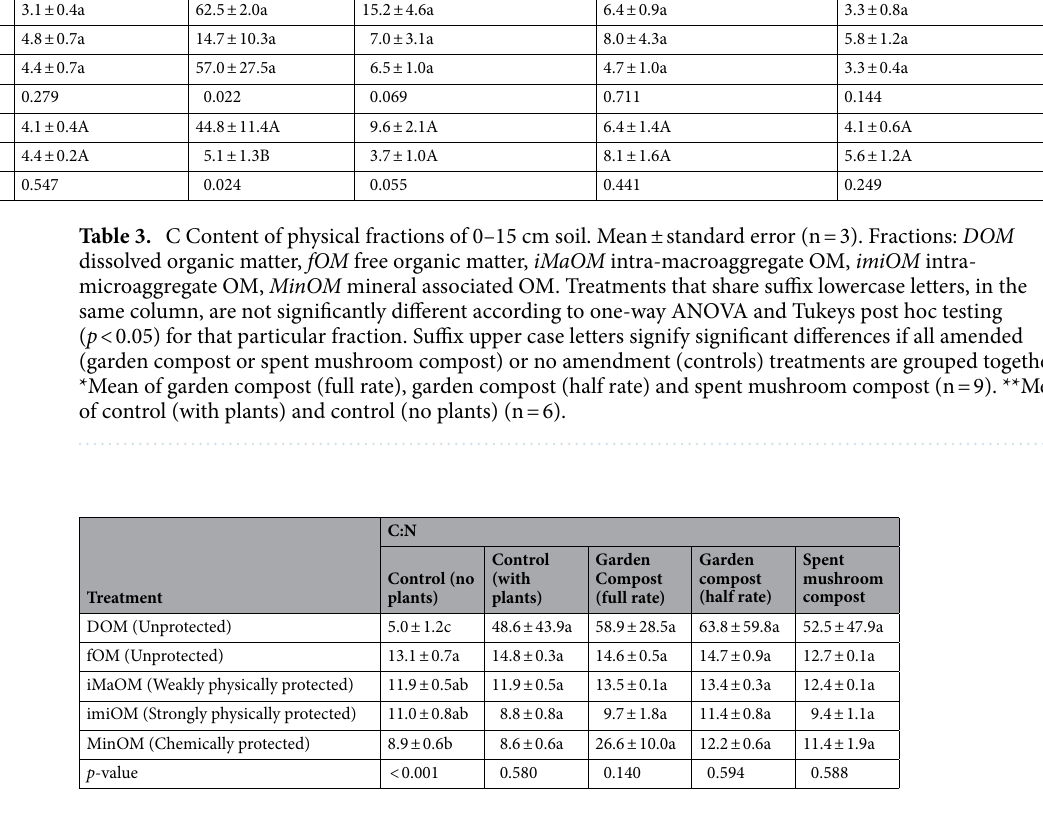
Table 4. C:N of physical fractions of 0–15 cm soil. Mean ± standard error (n = 3). Fractions: DOM dissolved organic matter, fOM free organic matter. iMaOM intra-macroaggregate OM, imiOM intra-microaggregate OM, MinOM mineral associated OM. Fractions that share suffix lowercase letters, in the same column, are not significantly different according to one-way ANOVA and Tukey’s post hoc testing (p < 0.05).